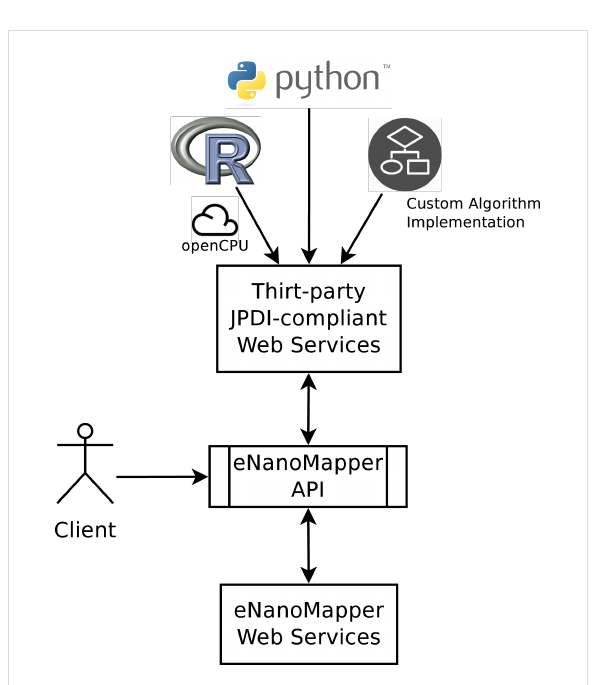
Figure 21: Example of a PMML document.